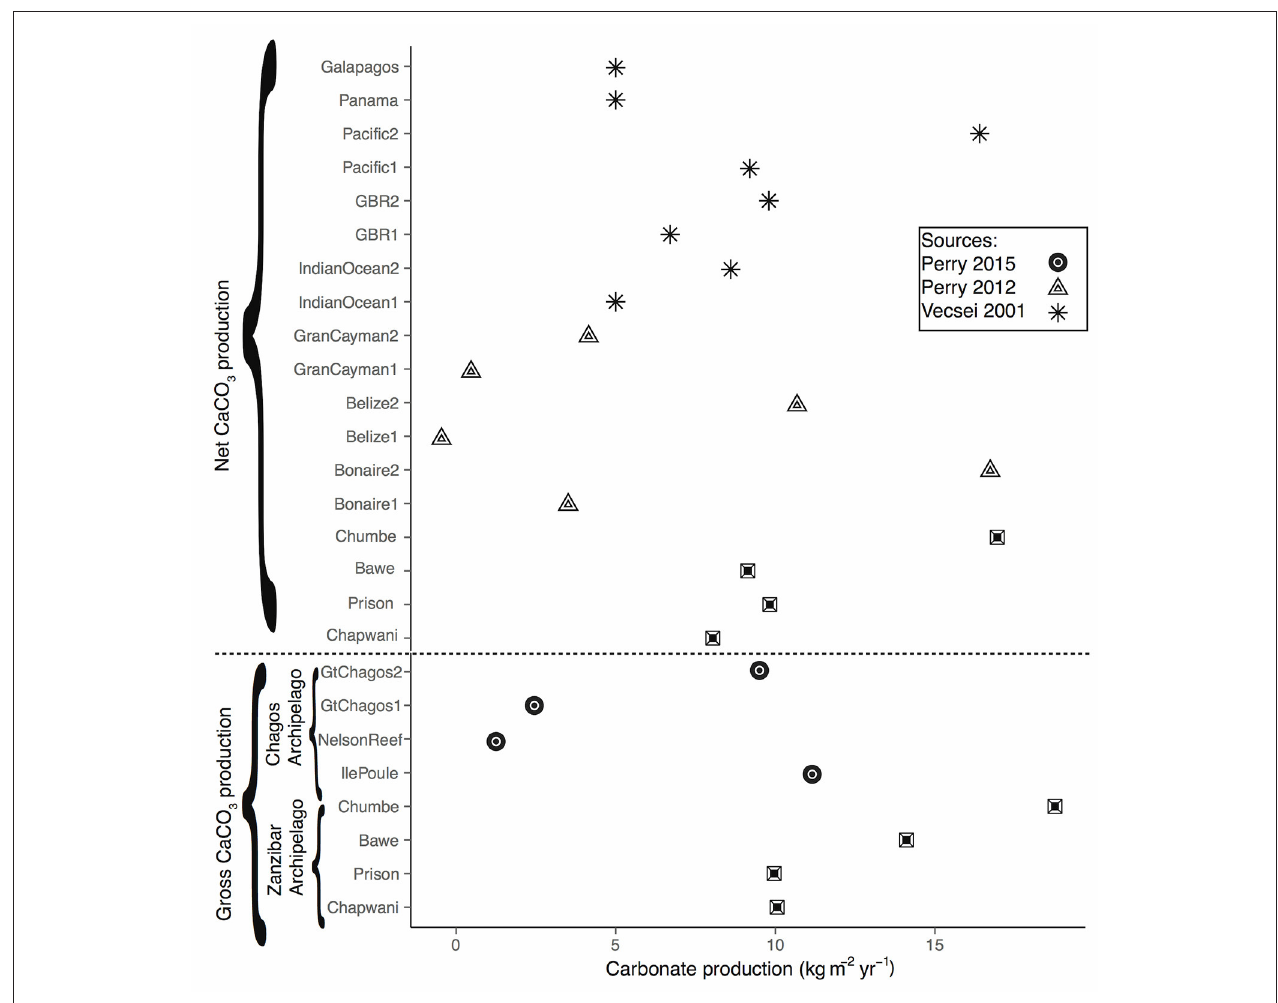
FIGURE 8 | Global comparison showing the CaCO 3 production at different locations. Filled dots present the gross calcium carbonate production in our study sites, squares show the gross calcium carbonate at Chagos Archipelago, as presented sensu (Perry et al., 2015), triangles shows the net calcium carbonate according to Perry et al. (2012) The numbering 1 and 2 indicate the minimum and maximum value. Asterisks represent the source Vecsei (2001). The numbering 1 and 2 indicate, either low or high ramose